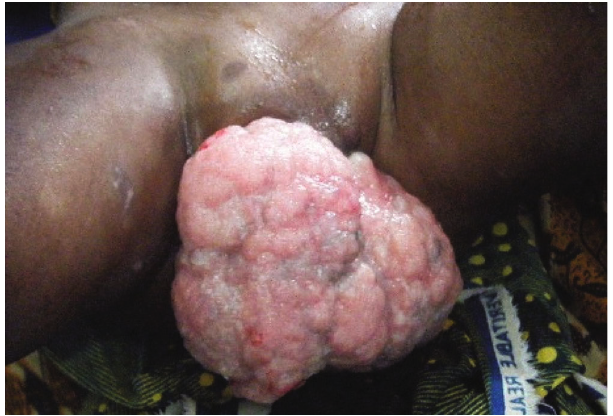
Figure 1: Signi fi cant (12 cm × 15 cm) tumoral spread to the whole vulvar and clitoris